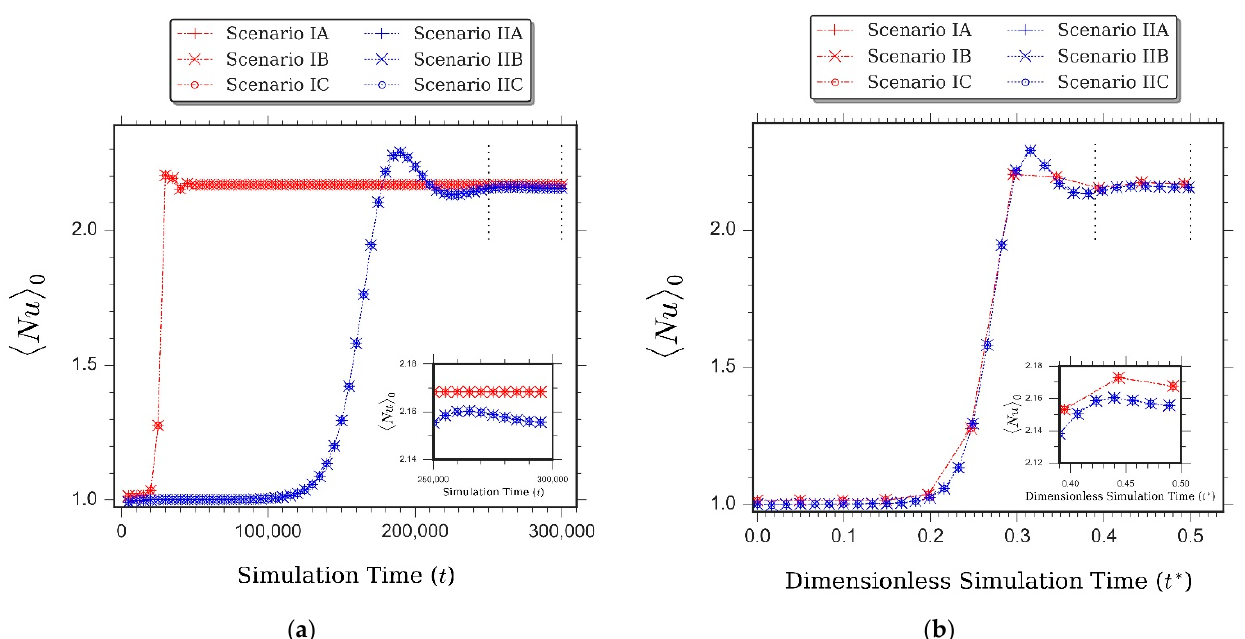
Figure 8. Profiles of average Nusselt number at the hot wall ⟨ Nu ⟩ 0 from different LBM scenarios during the unsteady period up to the accomplishment of steady-state condition of the Rayleigh-Bènard convection for aspect ratio = 1, Ra = 10 4 , Pr = 0.71 , τ υ = 0.6 , and Ma = 0.1 , showing computational behaviour with ( a ) dimensional simulation time t as the horizontal axis and ( b ) dimensionless simulation time t * as the horizontal axis. Figure insets display the magnification of the computational characteristics in the steady-state region of the simulation.